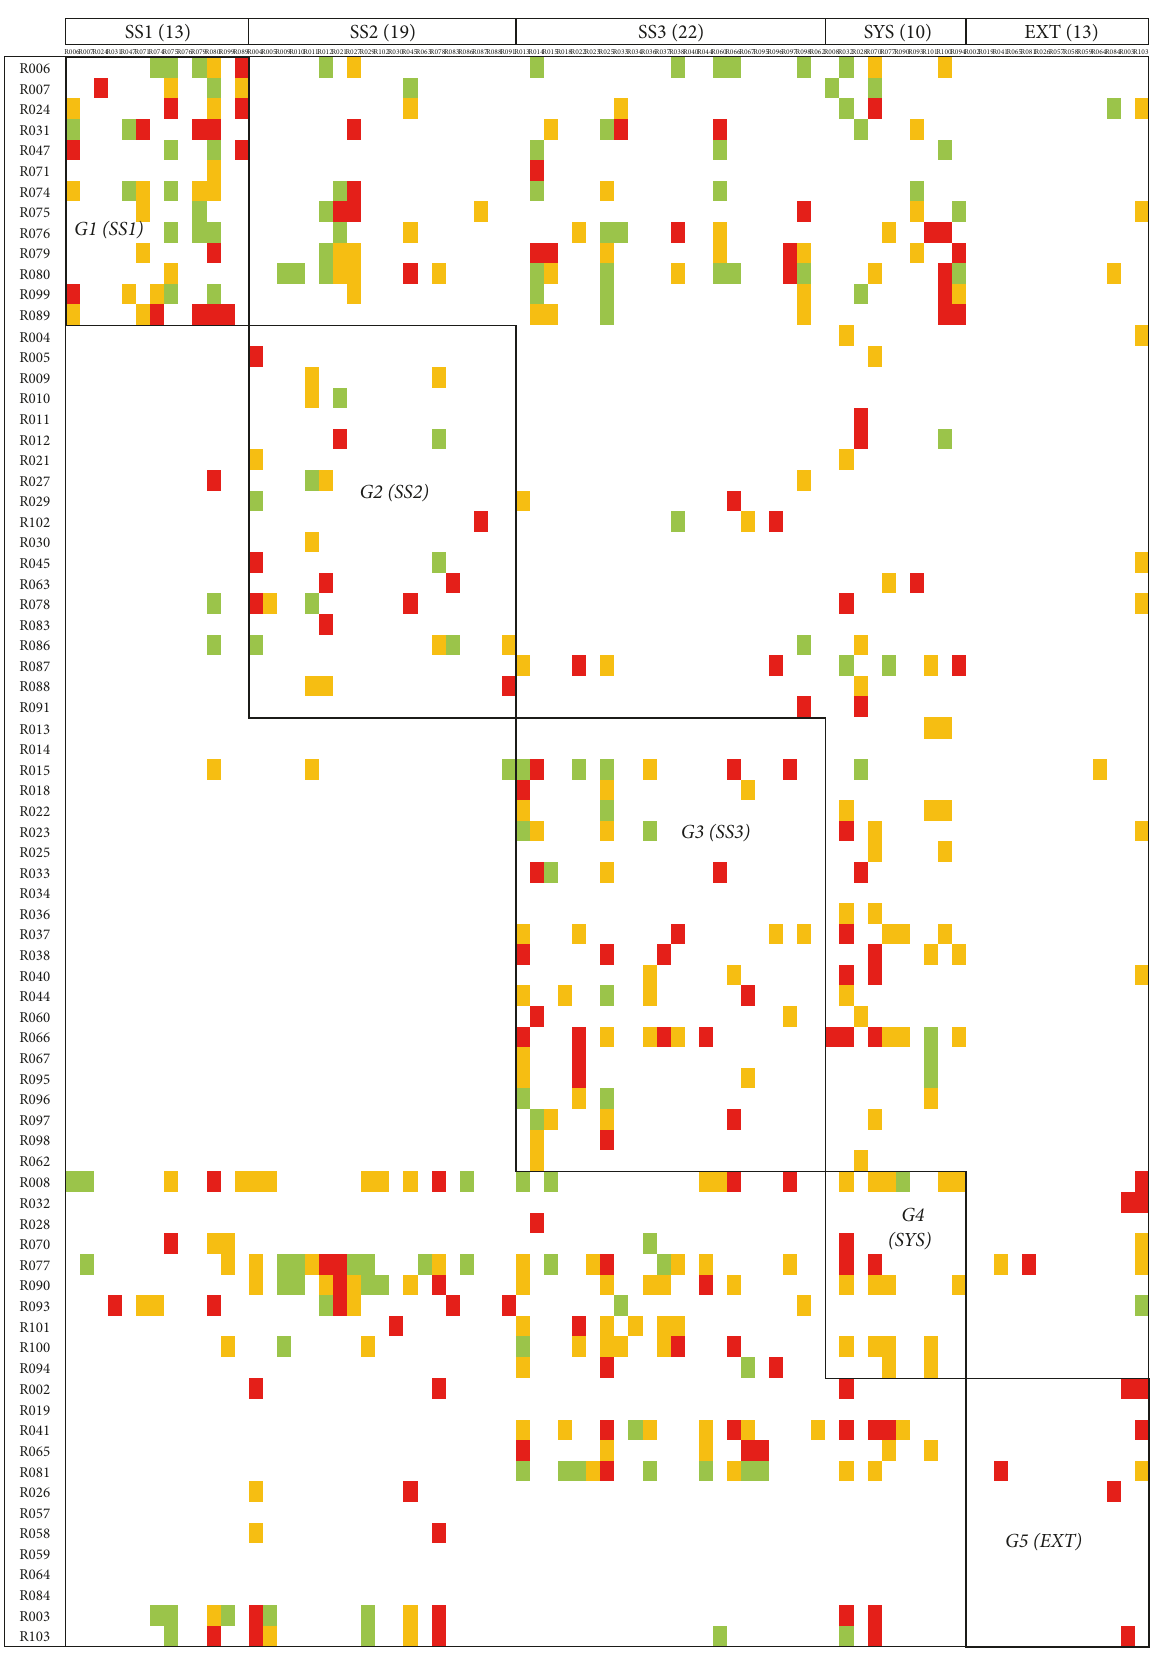
Figure 3: Initial configuration with 5 groups of risks organized among the system